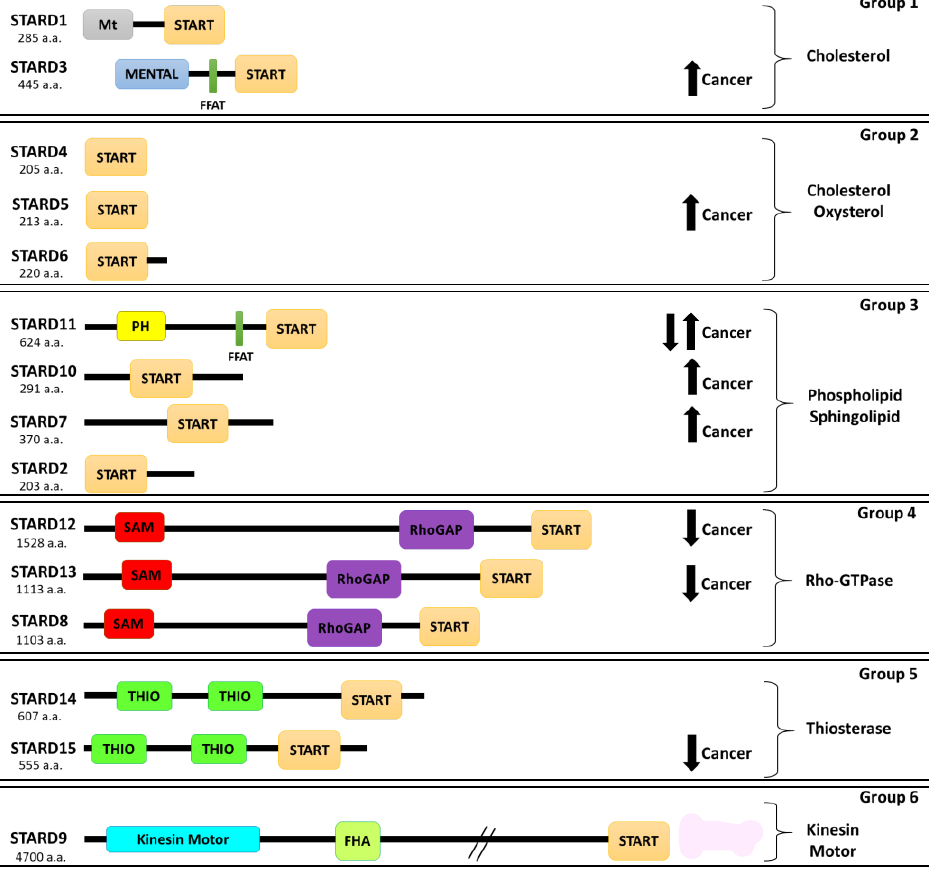
Figure 1. Schematic representation of the START proteins grouped into six subfamilies. START (StAR-related lipid-transfer domain), Mt (mitochondrial targeting sequence), MENTAL (MLN64 NH(2)-terminal domain), PH (pleckstrin homology domain), FFAT (two phenylalanines in an acidic tract), RhoGAP (Rho-GTPase-activating domain), SAM (sterile alpha motif domain), THIO (thioesterase active domain), and FHA (N-terminal Forkhead-associated domain). a.a. — amino acids. Arrows indicate overexpression (up) or downregulation (down) of protein in cancer.